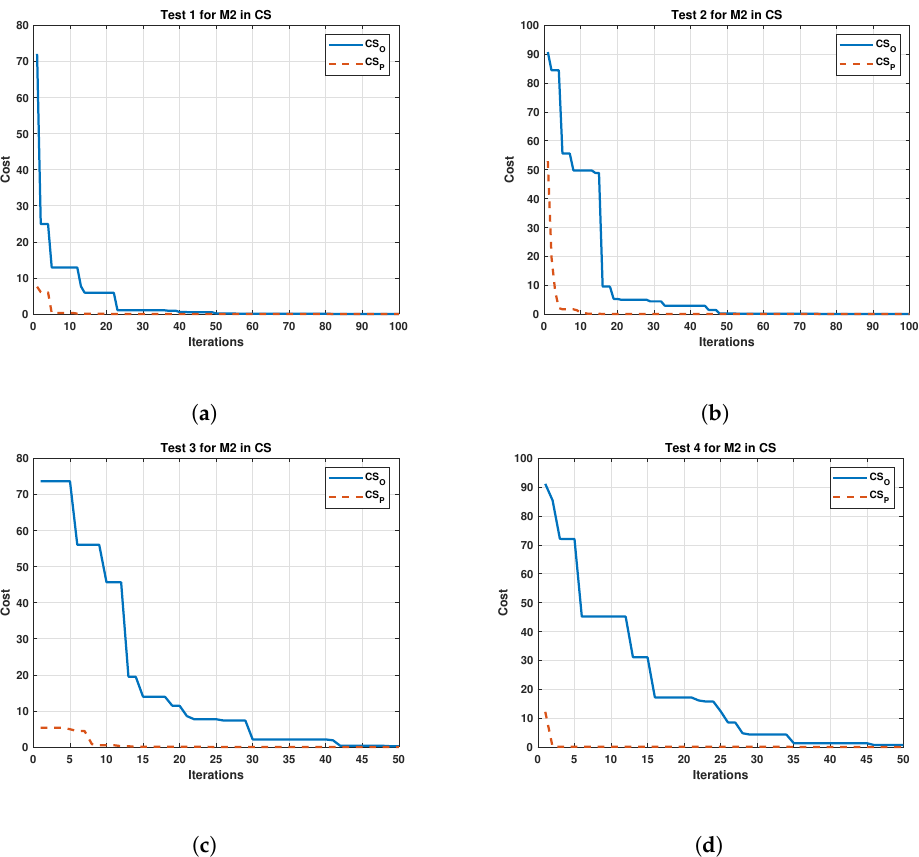
Figure 11. Comparison between the original and the proposed Cuckoo Search in four test for Motor 2. ( a ) cost and iterations of the Cuckoo Search in test 1 for Motor 2; ( b ) cost and iterations of the Cuckoo Search in test 2 for Motor 2; ( c ) cost and iterations of the Cuckoo Search in test 3 for Motor 2; ( d ) cost and iterations of the Cuckoo Search in test 4 for Motor